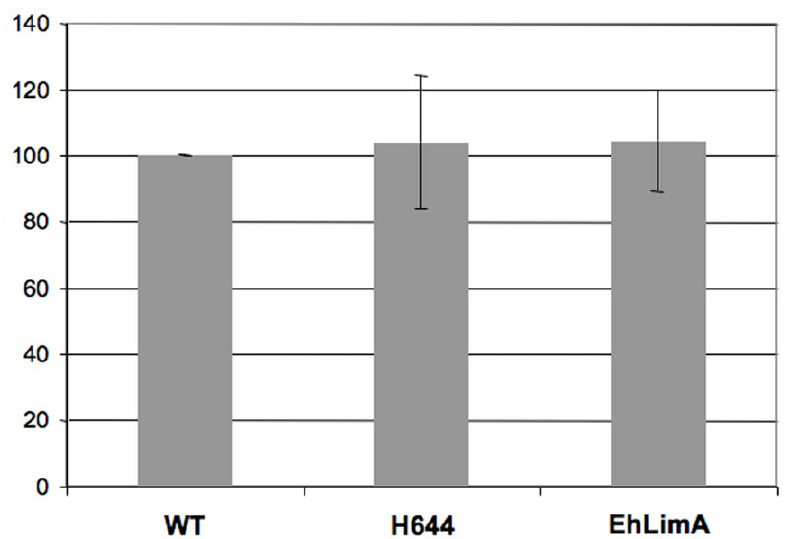
Figure 8. Fluid-phase endocytosis is not reduced in E.histolytica cells over-expressing H644 or EhLimA. Wild-type (WT) or transgenic cells were incubated with the fluid-phase marker, FITC-dextran for 30 minutes, lysed, and analyzed for internalized FITC-dextran using spectrofluorimetry. The data represent the mean 6 S.D. of $ 3 experiments. Amoebae over-expressing H644 or EhLimA exhibit normal uptake of fluid-phase marker suggesting that these cell lines do not have wide-spread defects in endocytosis.